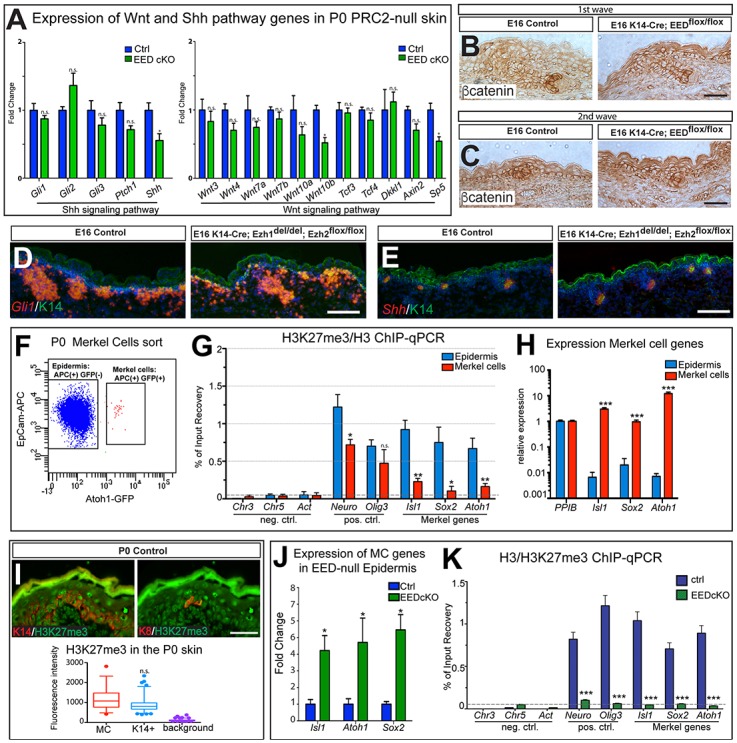
Loss of EED does not affect the hair follicle microenvironment, but leads to upregulation of Merkel cell differentiation genes.(A-E) Shh and Wnt pathways do not appear to be majorly altered in PRC-null developing skin. (A) RT-qPCR analysis of Shh pathway genes shows no significant difference in their expression in P0 EED cKO (K14-Cre; EEDflox/flox) compared to control epidermis, while Shh expression is slightly reduced in EED-null compared to control epidermis (Gli1, p = 0.2000; Gli2, p = 0.1143; Gli3, p = 0.3429; Ptch1, p = 0.1143; Shh, p = 0.0286). RT-qPCR analysis of Wnt pathway genes shows no significant difference in expression of most genes in P0 EED cKO compared to control epidermis (Wnt3, p = 0.4857; Wnt4, p = 0.1143; Wnt7a, p = 0.3429; Wnt7b, p = 0.4857; Wnt10a, p = 0.2000; Wnt10b, p = 0.0286; Tcf3, p = 0.6857; Tcf4, p = 0.4857; Dkkl1, p = 0.6857; Axin2, p = 0.2000; Sp5, p = 0.0286). (B,C) Immunohistochemistry staining for β-catenin does not show major differences in expression or nuclear staining in first wave (B) or second wave (C) hair follicles in EED cKO skin compared to control at E16. Note that, as has been previously described, the stratum corneum is prematurely acquired in the PRC2-null E16 embryo [51]. (D,E) In situ hybridization for Gli1 RNA (D) and Shh RNA (E) shows no major changes in expression in Ezh1/2 2KO (K14-Cre; Ezh1del/del;Ezh2flox/flox) skin compared to control at E16. (F) FACS scheme for Merkel cell (MC) sorting. After gating on singlets and live cells, EpCAM-APC staining was used to gate on all epidermal cells and Atoh1-GFP labels Merkel cells. EpCAM-APC(+) Atoh1-GFP(-) cells were sorted as epidermal controls. (G) ChIP-qPCR showing significantly lower levels of H3K27me3 at Merkel genes, Isl1, Sox2, and Atoh1, in FACS-sorted Merkel cells compared to FACS-sorted epidermal cells. (Neuro, p = 0.0411; Olig1, p = 0.0200; Isl1, p = 0.0022; Sox2, p = 0.0194; Atoh1, p = 0.0050). (H) RT-qPCR showing specific expression of MC signature genes Isl1, Sox2, and Atoh1 in FACS-sorted Merkel cells compared to FACS-sorted epidermal cells (Isl1, p = 0.0004; Sox2, p = 0.0004; Atoh1, p = 0.0004) (I) IF staining showing that Krt8(+) (K8) MCs have the H3K27me3 mark in P0 control Krt14(+) (K14) epidermis. Krt14(+) cells serve as a positive control for H3K27me3 staining. Quantification of H3K27me3 staining intensity (below) (Kruskal-Wallis test p<0.0001; MC vs. K14(+), n.s. p>0.05). (J) RT-qPCR in skin epidermal samples showing upregulation of Merkel cell genes Isl1, Atoh1 and Sox2 in EED cKO animals compared to control. The average of at least three animals is presented compared to Cre(-) siblings (WT) (Isl1, p = 0.0286; Atoh1, p = 0.0286; Sox2, p = 0.0286). (K) ChIP-qPCR analysis in skin epidermal samples from WT and EED cKO animals showing specific H3K27me3 signal at the Isl1, Sox2, and Atoh1 promoters. Actin is used as a negative control, and Neuro and Olig3 are used as positive controls. Dotted line shows the level of the negative region (all p<0.0001). Scale bars: (B,C,I): 25 μm; (D,E): 100μm.